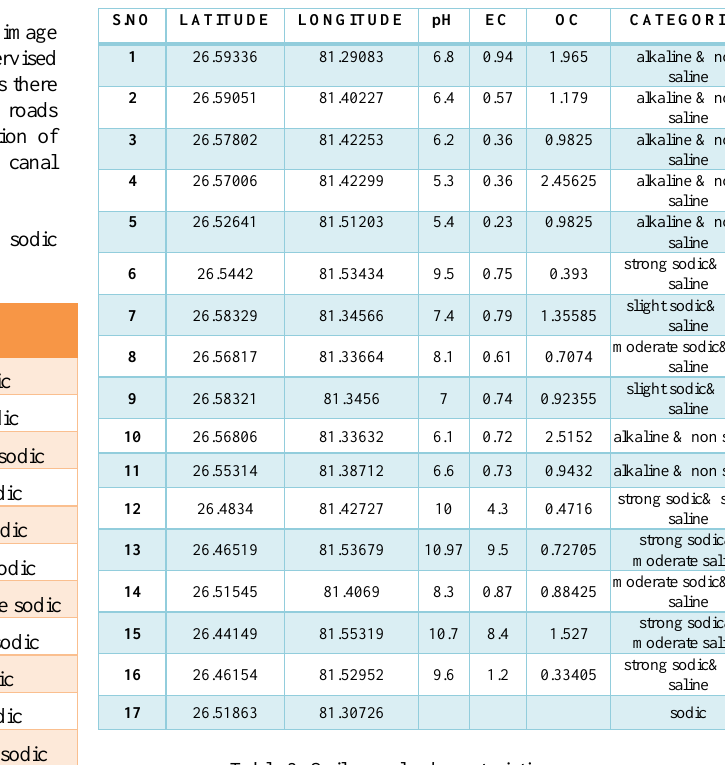
Table 3: Soil sample